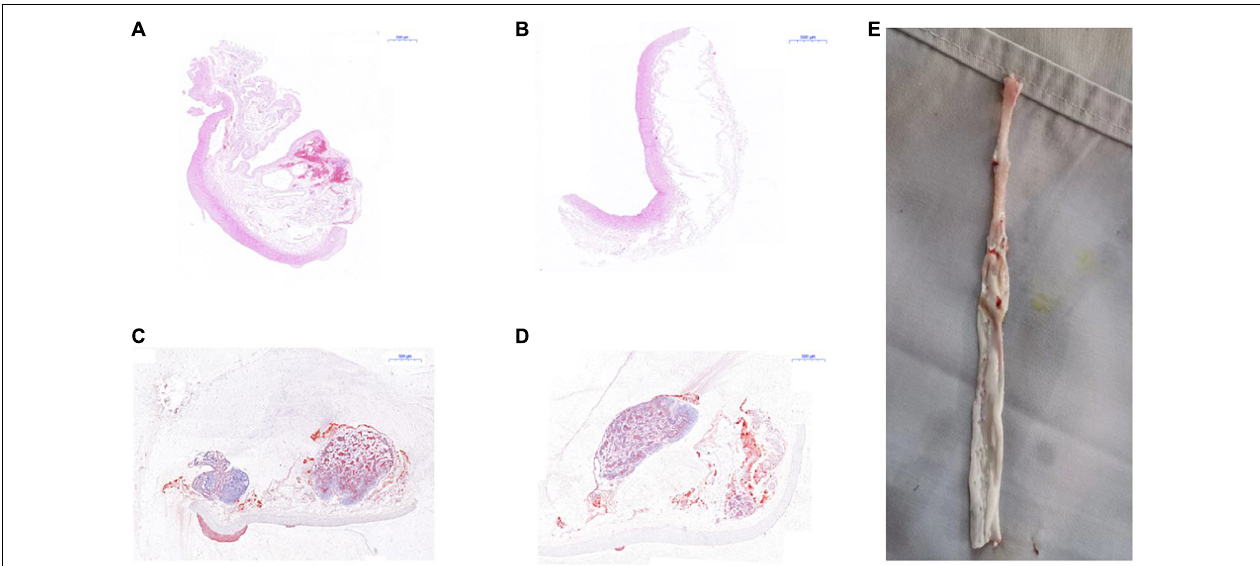
FIGURE 9 | Pathological examination of abdominal aorta in rabbits. (A) H&E staining indicated atherosclerotic plaques formation in the abdominal aorta of New Zealand rabbits in the model group, (B) while there was no plaques formation in abdominal aorta of rabbits in the control group; (C) red “O” staining suggested atherosclerotic plaques formation in the abdominal aorta of New Zealand rabbits in the model group, (D) while there was no sign of plaques formation in the abdominal aorta of rabbits in the control group. (E) The specimen of the abdominal aorta of rabbits in the model group showed that the wall of the artery was more thickened, less smooth, and had remarkable atherosclerotic plaques